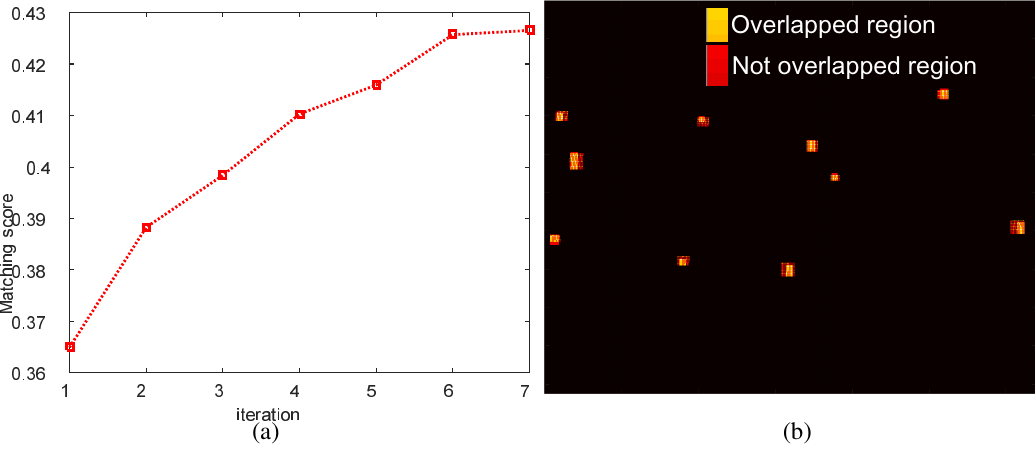
Figure 14. Proposed homography optimization by RANdom SAmple Region Consensus (RANSARC).